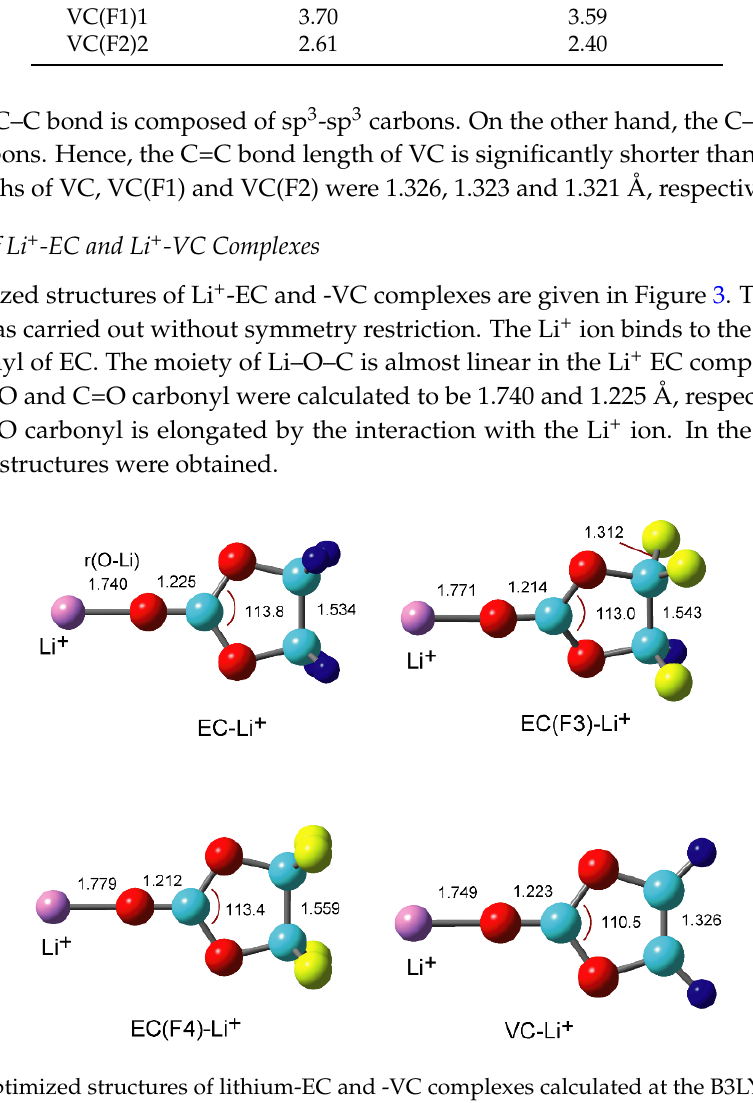
Figure 3. Optimized structures of lithium ‐ EC and ‐ VC complexes calculated at the B3LYP/6 ‐ 31G(d) level. Bond lengths are in Å. level. Bond lengths are in